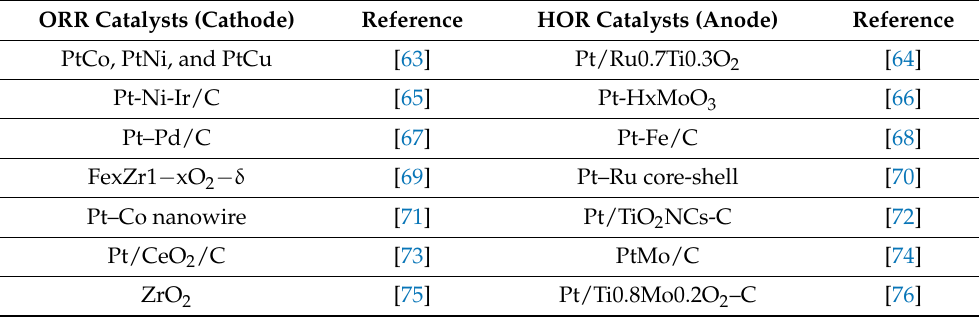
Table 3. Anode and cathode catalyst material in PEMFC. ORR Catalysts